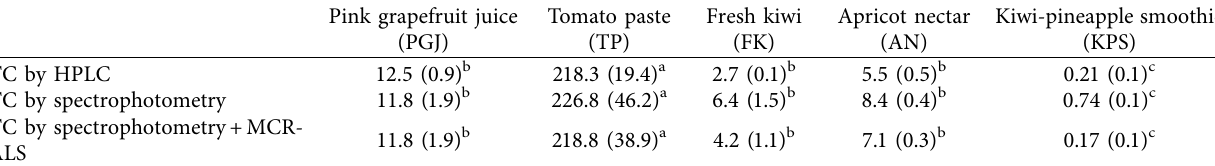
Table 3: Total carotenoids in mg.kg-1 of fruit extracts obtained with HPLC, spectrophotometry, and spectrophotometry+MCR-ALS.